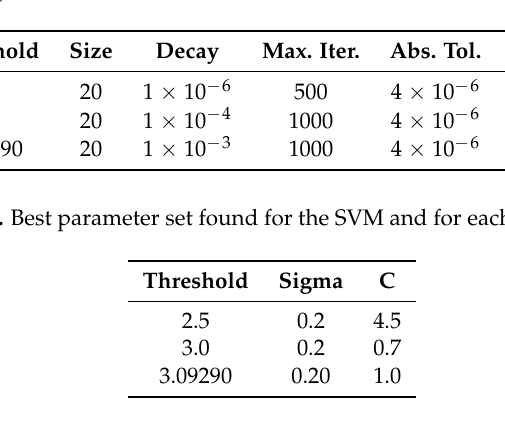
Table 4. Best parameter set found for the feed forward NN and for each threshold.